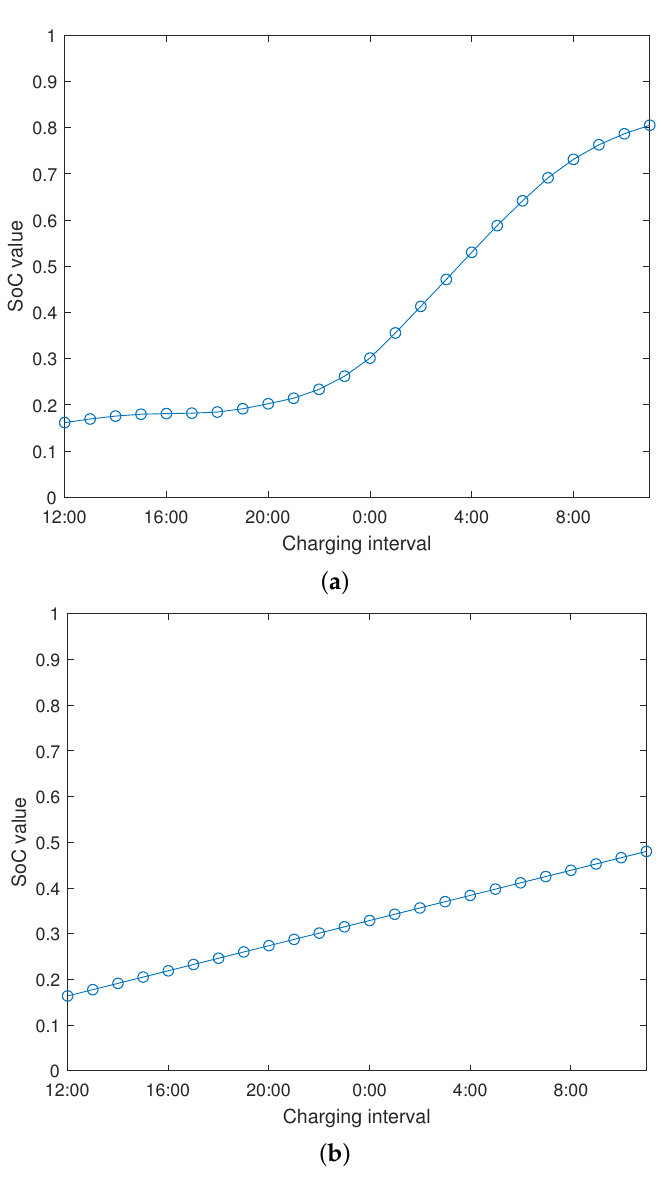
Figure 3. Evolution of the PEV’s state-of-charge (SoC) for Algorithm 1. ( a ) Without replay attack; ( b ) under replay